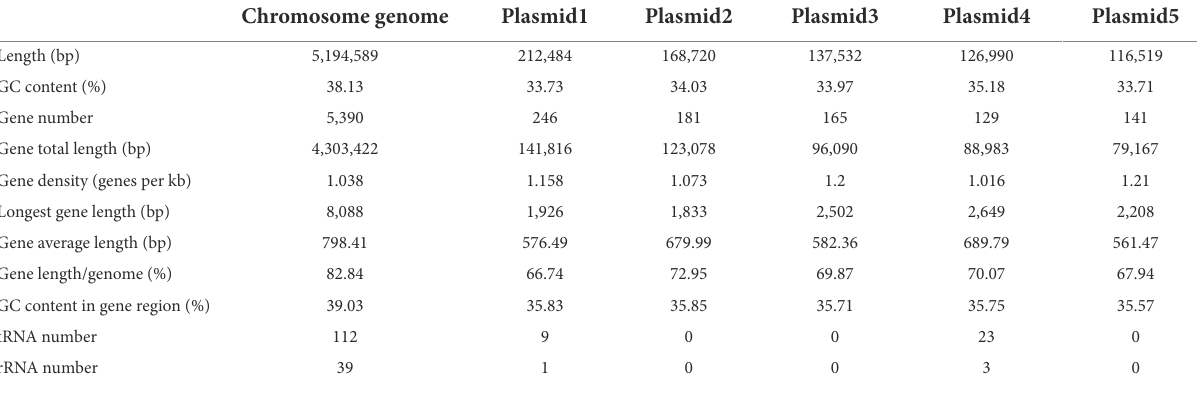
TABLE 2 Basic features of B. aryabhattai LAD chromosome genome and